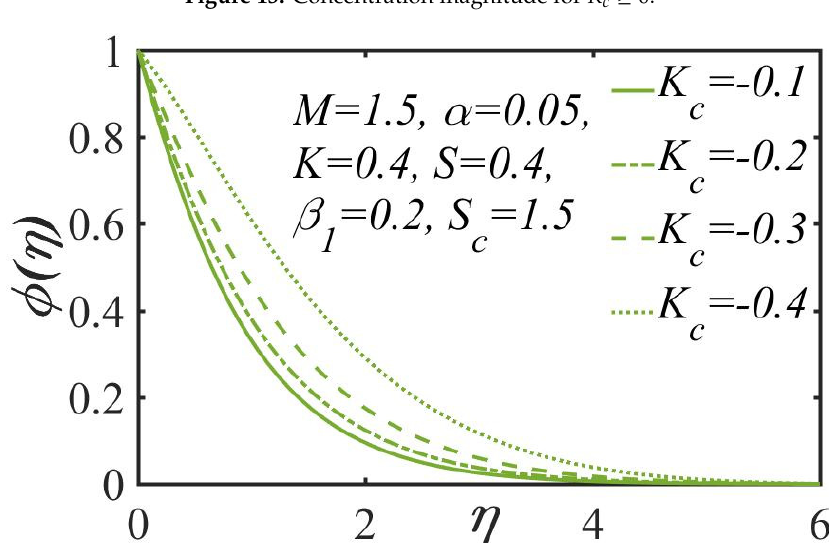
Figure 14. Concentration magnitude for K c < 0 .